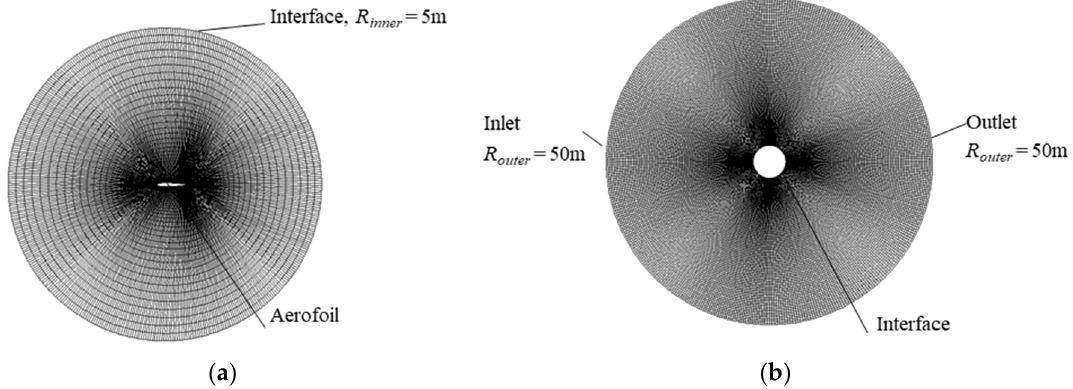
Figure 1. The rotating (inner) mesh and the static (outer) mesh. ( a ) Rotating mesh; ( b ) static mesh.